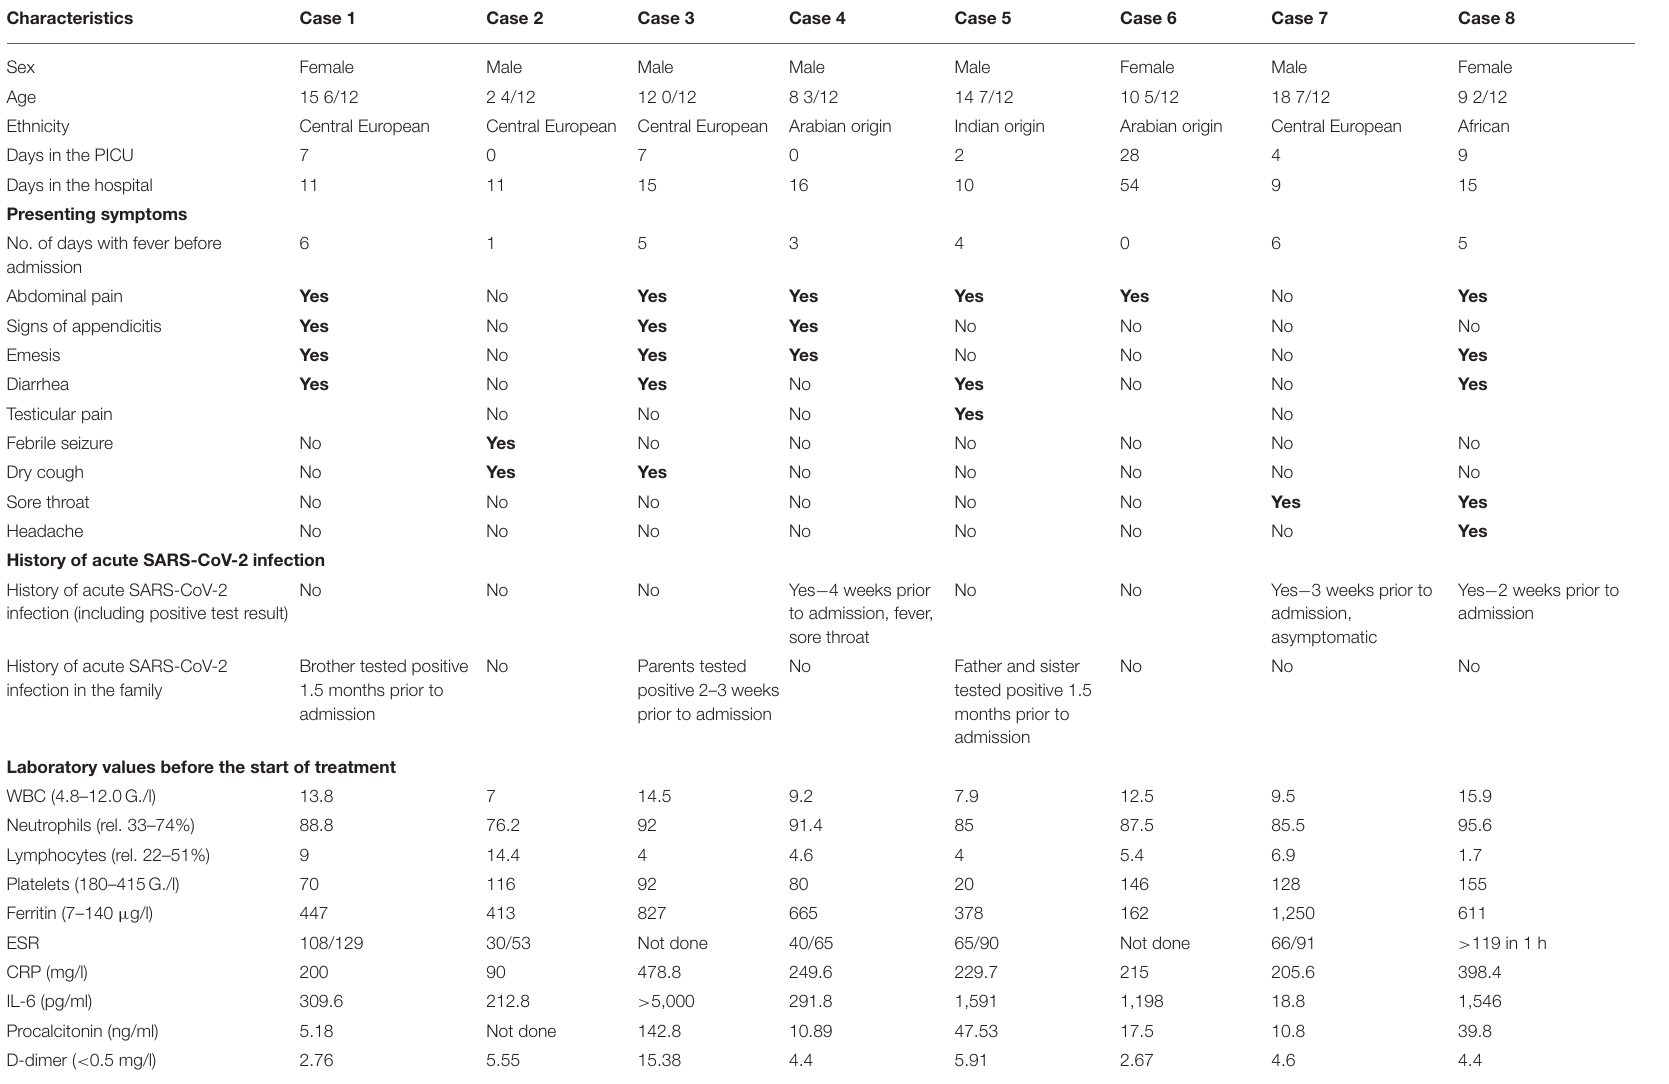
TABLE 1 | Patient characteristics.